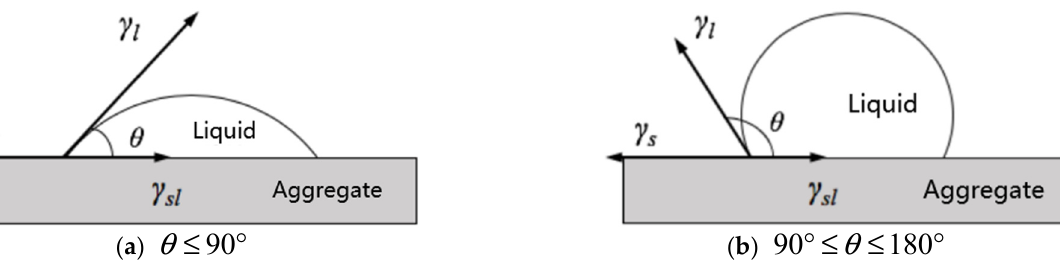
Figure 9. Schematic diagram of contact angle measurement by sessile drop method.